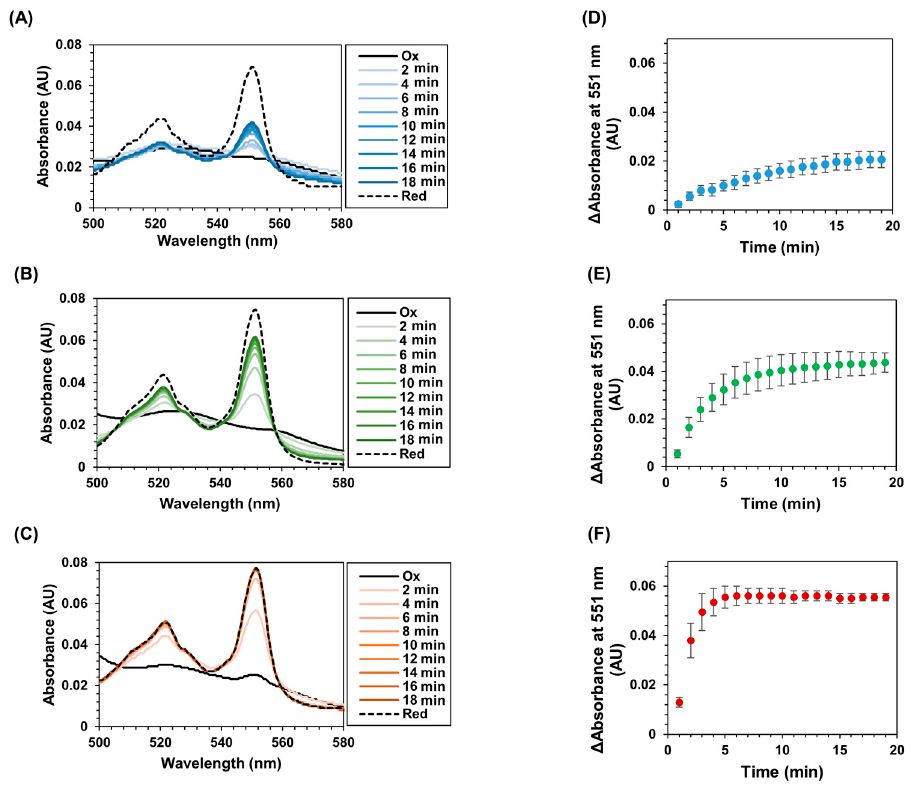
Figure 3. Time-dependent spectroscopic analyses of CYTc-SC/ST-Enzyme complexes. ( A – C ): Time- dependent absorbance spectrum changes of CYTc-SC/ST-Enzyme complexes in the presence of substrate. Absorbance spectra between 350 and 600 nm were recorded, and the range between 500 and 580 nm at every minute after the addition of substrate solution to the ( A ) CYTc-SC/ST-GDH, ( B ) CYTc-SC/ST-DAAOx, and ( C ) CYTc-SC/ST-LOx are shown. Black-solid line (Ox) and black-dashed line (Red) indicate each CYTc-SC/ST-Enzyme complex sample in oxidized state and reduced state treated with sodium dithionite, respectively. Recorded spectra in each minute were superimposed to observe time-dependent spectral change after the addition of substrate. Original recorded spectra between 350 and 600 nm are shown in Figure S3. ( A – C ): UV-vis spectrum analysis revealed the absorbance change at 551 nm of CYTc-SC/ST-Enzymes after addition of substrate. Absorbance spectra were measured every minute after the addition of substrate solution to the ( D ) CYTc-SC/ST-GDH, ( E ) CYTc-SC/ST-DAAOx, and ( F ) CYTc-SC/ST-LOx. The change in absorbance was calculated by subtracting the absorbance of the oxidized state from the absorbance recorded each minute. All experiments were performed in triplicate. Error bars represent the standard deviation for triplicated experiment.